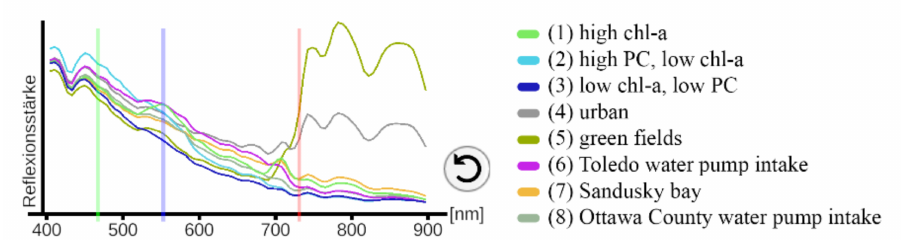
Figure 11. Spectral signatures as seen in the app UI and their origins. The circle arrow resets all signatures when they get too cluttered. The signatures are numbered as in Figure 9 (Source: